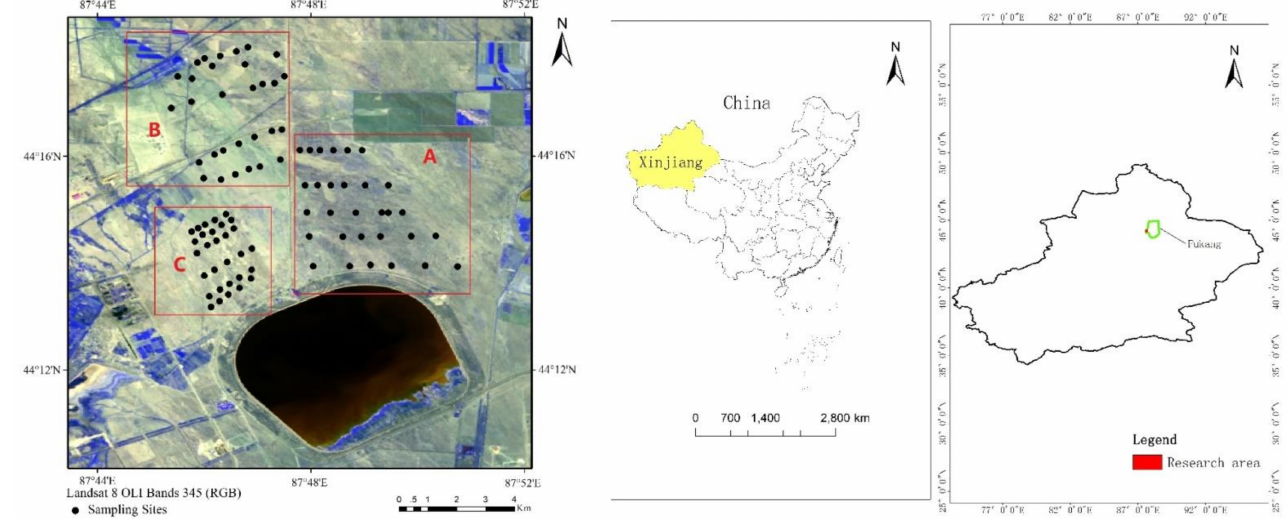
Figure 1. Distribution map of the study area and soil sampling point